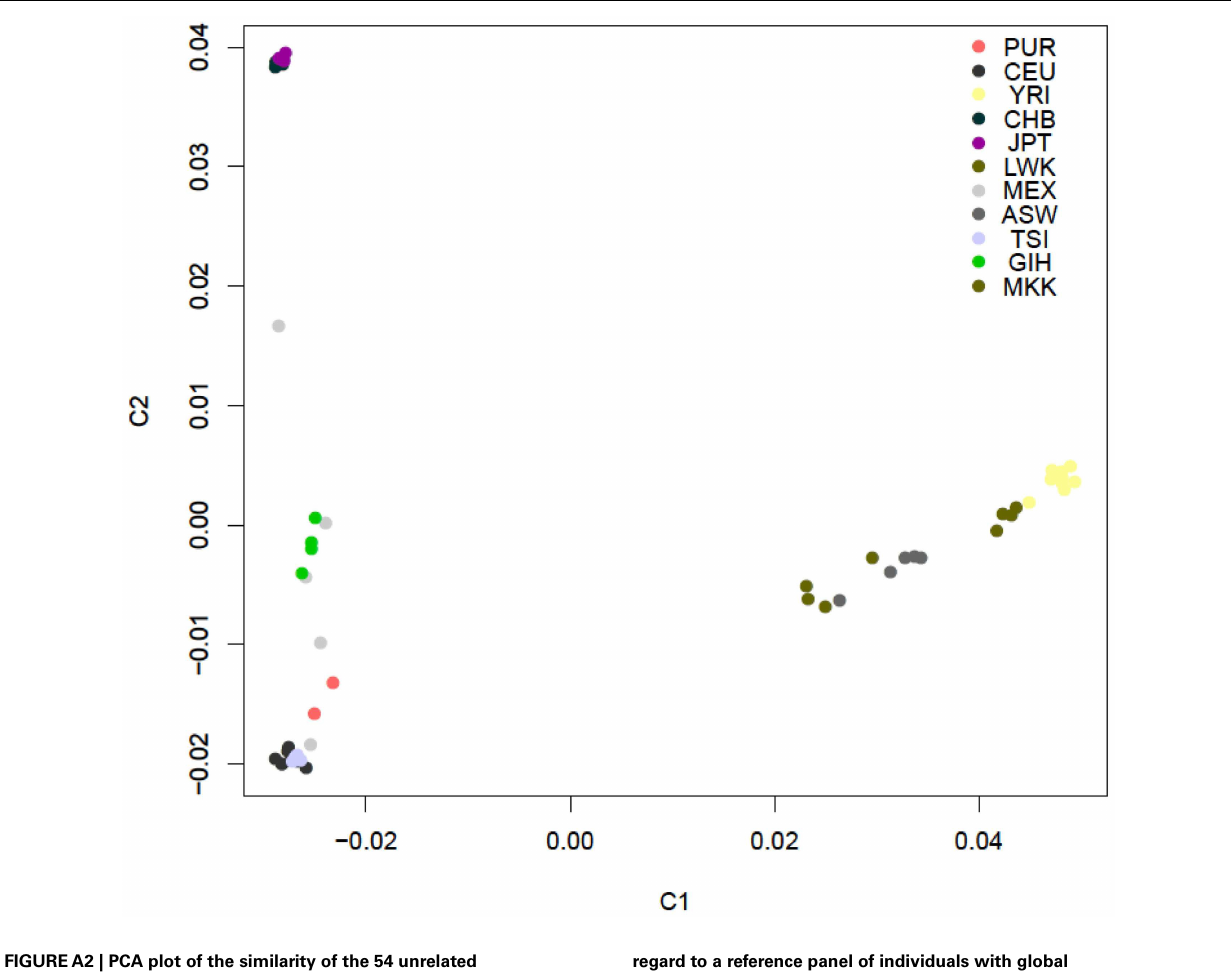
regard to a reference panel of individuals with global ancestries (shading according to population is provided by the